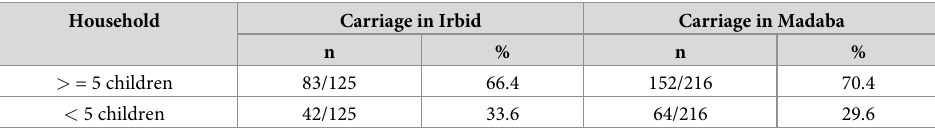
Table 2. Carriage in Irbid and Madaba with household of > = 5 or less than 5 children for both winter seasons. Household Carriage in Irbid Carriage in Madaba